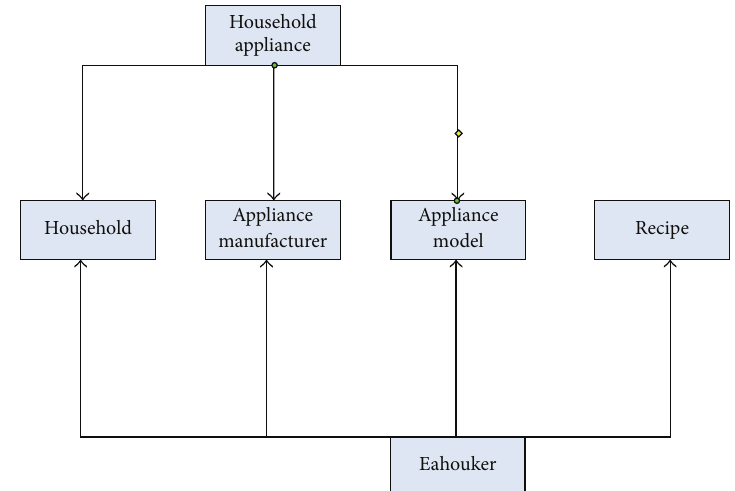
Figure 1: Concepts and relations